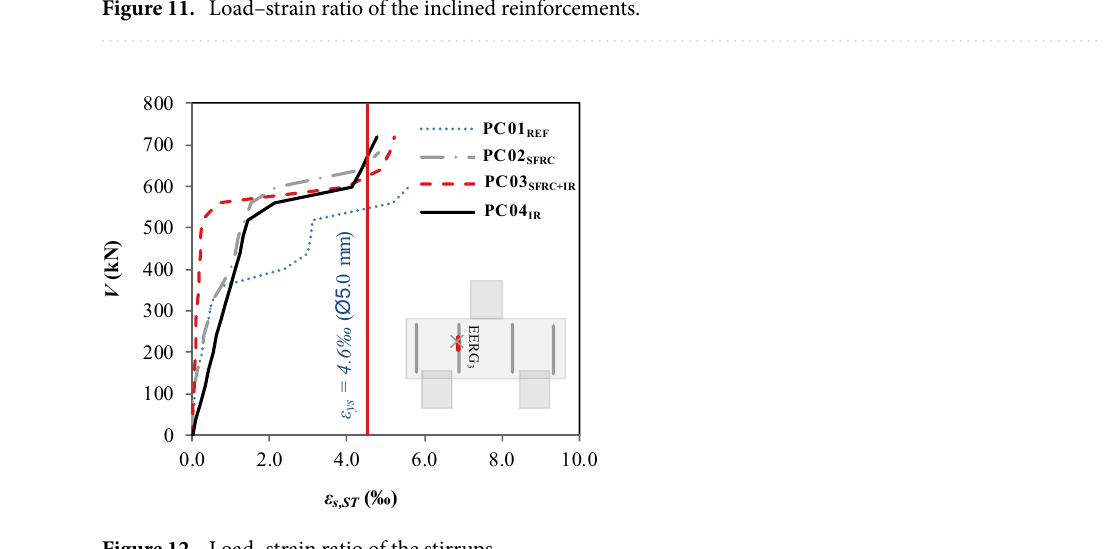
Figure 12. Load–strain ratio of the stirrups.